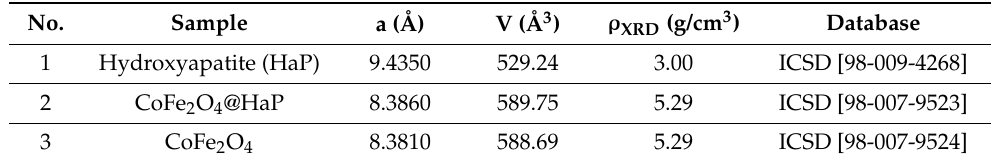
Table 2. Experimental data obtained from the interpretation of the diffractograms of the three synthesized samples.